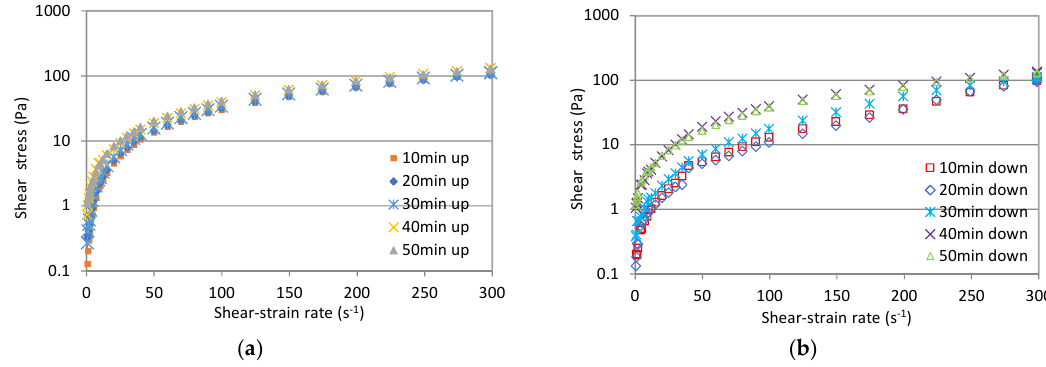
Figure 3. Shеar strеss curvеs of grout with 0.03% polypropylеnе (PP) fibеrs: ( a ) up curvе, ( b ) down curvе.